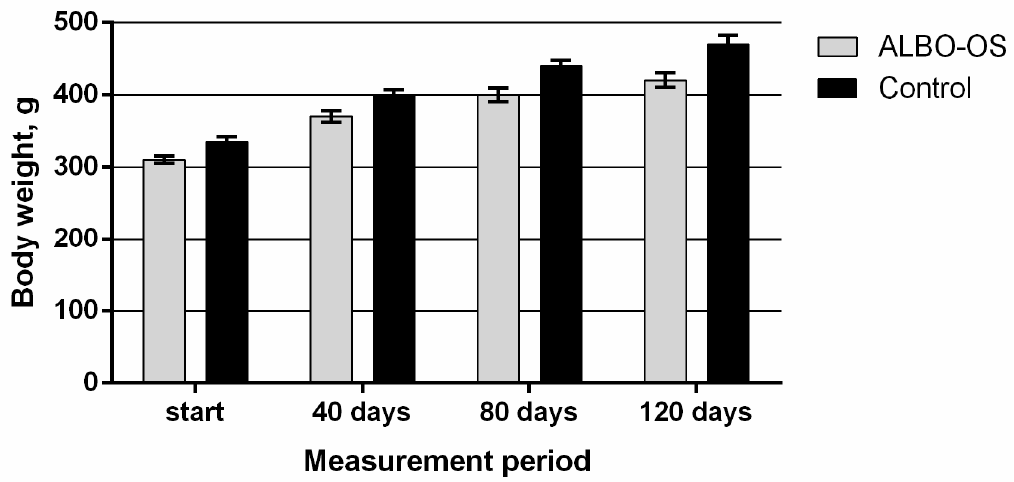
Figure 2. Average body weights of experimental and control animals during the study of chronic systemic toxicity of ALBO-OS.